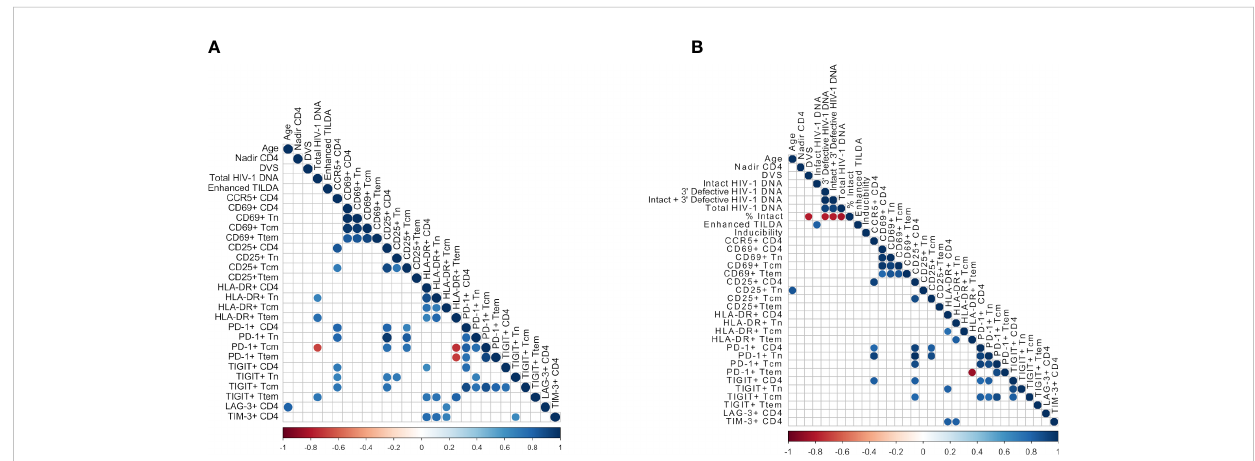
FIGURE 4 Correlograms depicting signi fi cant positive and negative correlations between assay measurements based on Spearman ’ s correlation. (A) Correlations between all samples (n = 10) and (B) Correlations between samples from individuals with HIV-1 subtype B (n = 7), including inferred intact provirus by IPDA. Blue color represents a positive correlation and red color represents a negative correlation. Signi fi cance was determined using Spearman ’ s correlation test, at p<0.05.